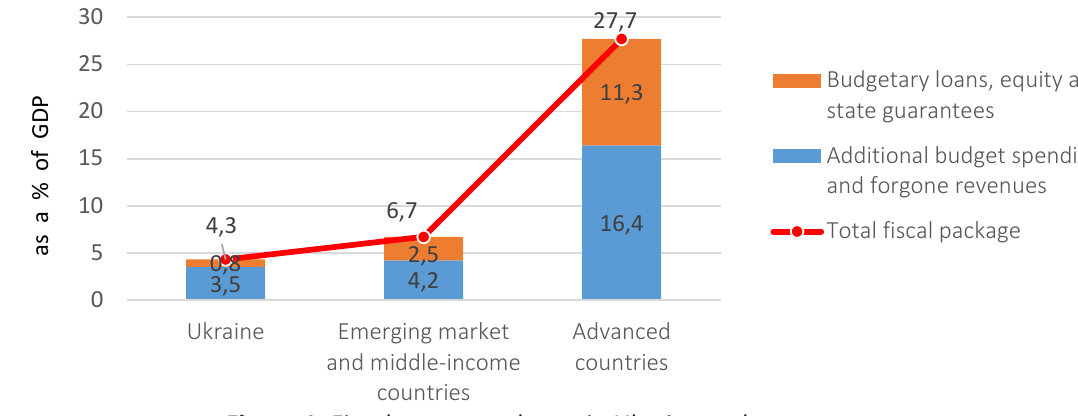
Figure 1. Fiscal rescue packages in Ukraine and country groups by main components as of March